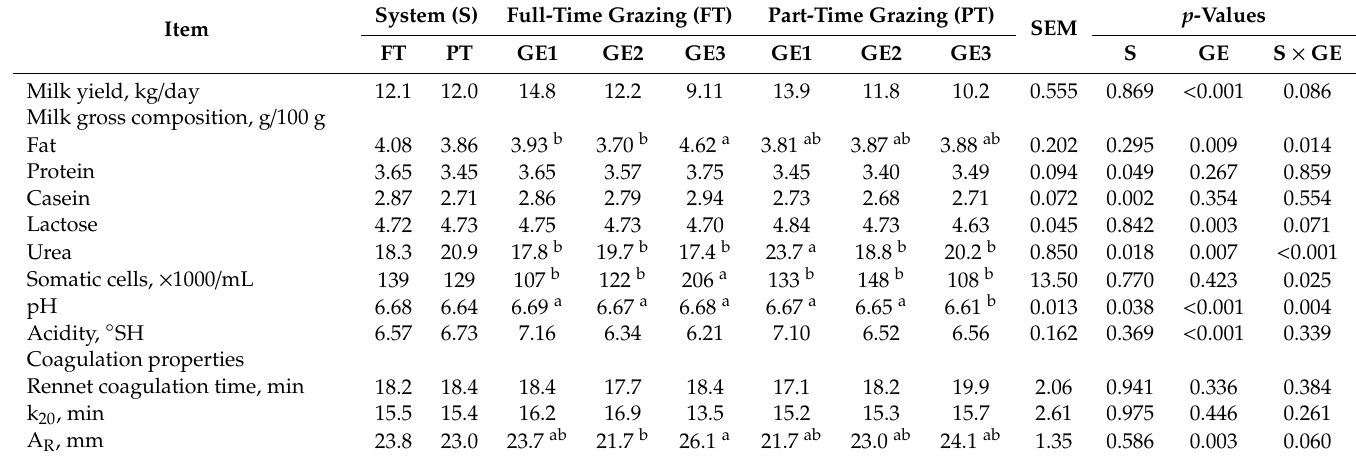
Mean duration of bouts, min Rumination Idling Table 4. Least square means of milk yield, composition, and milk coagulation properties in the two pasture management systems and the three GEs. System (S) Full-Time Grazing Item